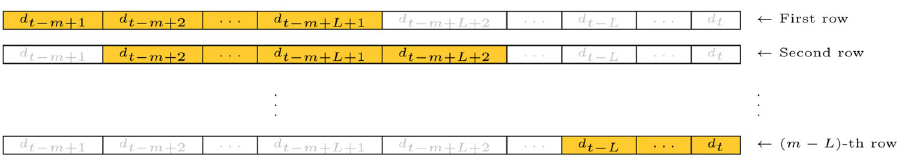
Fig 5. The data included when fitting a LASSO regression model on day t , where m = 40, L = 5 for models under H 1 a and H 1 b , and L = 3 for models under H 2 . d t represents the data available on day t